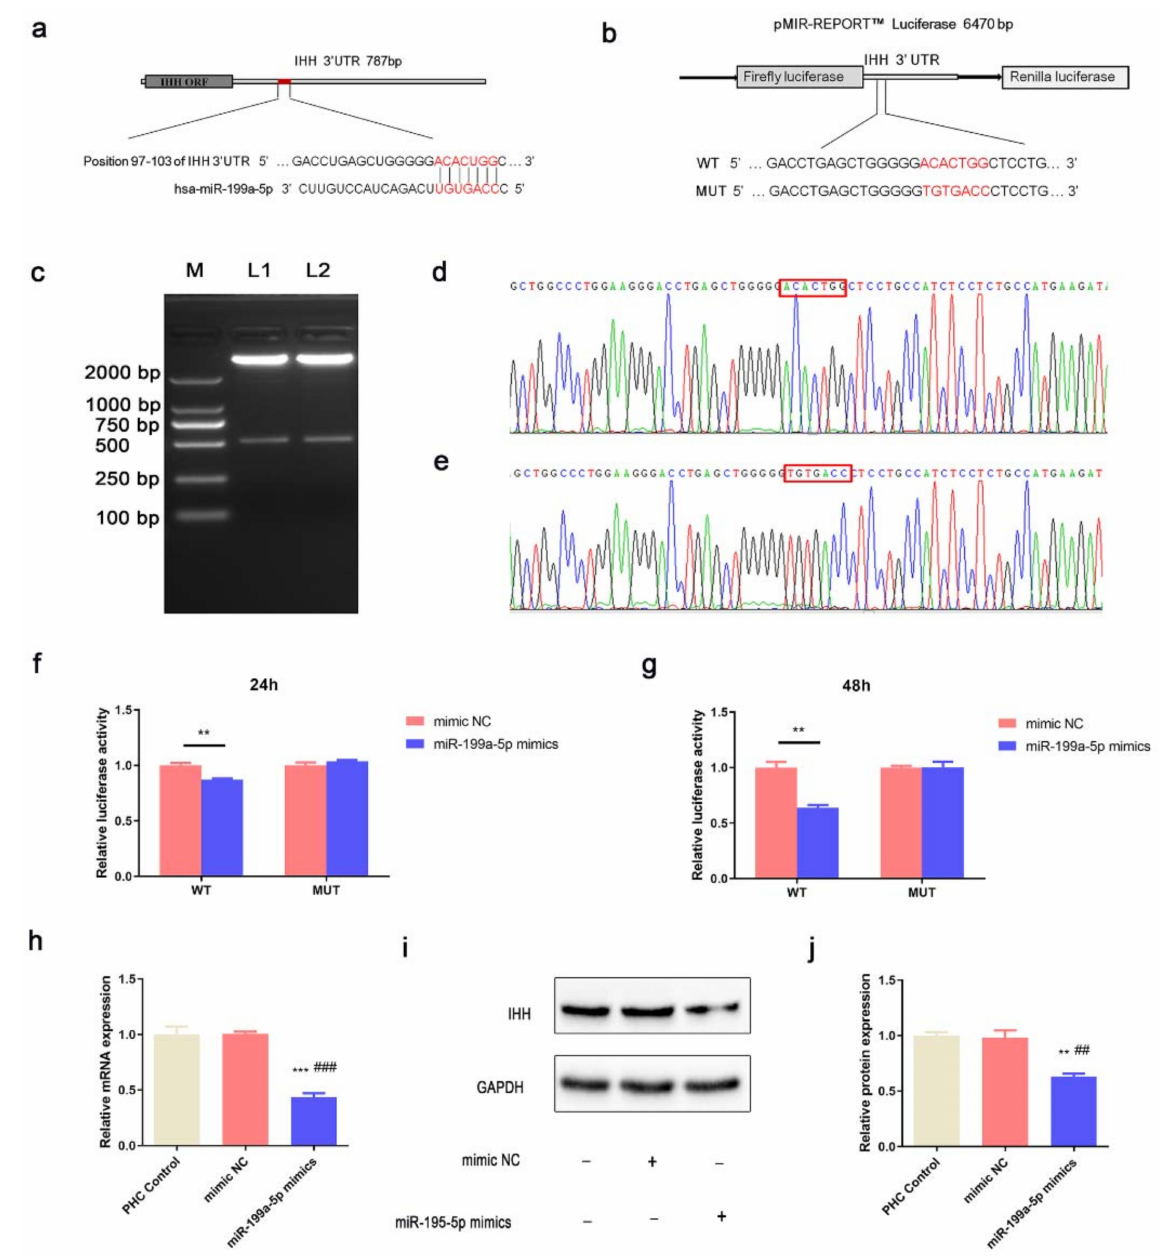
Figure 3. miR-199a-5p directly regulated the IHH expression in PHCs. ( a ) Schematic diagram of the base pairing between miR-199a-5p and IHH 3 (cid:48) UTR. The putative seed-pair region is shown in red. ( b ) Schematic diagram of the WT and MUT constructs. The putative seed sequence and point mutations in the constructs are shown in red. ( c ) Results of the restriction digestion. M represents the DL2000 marker, lane 1 and lane 2 show the restriction digestion results of WT and MUT constructs respectively. ( d , e ) Partial sequencing results of WT and MUT constructs. Nucleotides in the red boxes represent the binding site in IHH 3 (cid:48) UTR. ( f , g ) Dual-luciferase reporter assay of mimic NC and miR-199a-5p mimics co-transfected with WT and MUT constructs into the HEK293T after 24 h and 48 h. ( h ) Relative mRNA expression of the IHH in PHCs after 24 h of transfection. ( i ) Western blot of IHH in PHCs after 48 h of transfection. ( j ) Statistical analysis of the western blot results from 3 independent experiments. (** p < 0.01, *** p < 0.001 versus mimic NC; ## p < 0.01, ### p < 0.001 versus miR-199a-5p mimic group; n = 3 for each